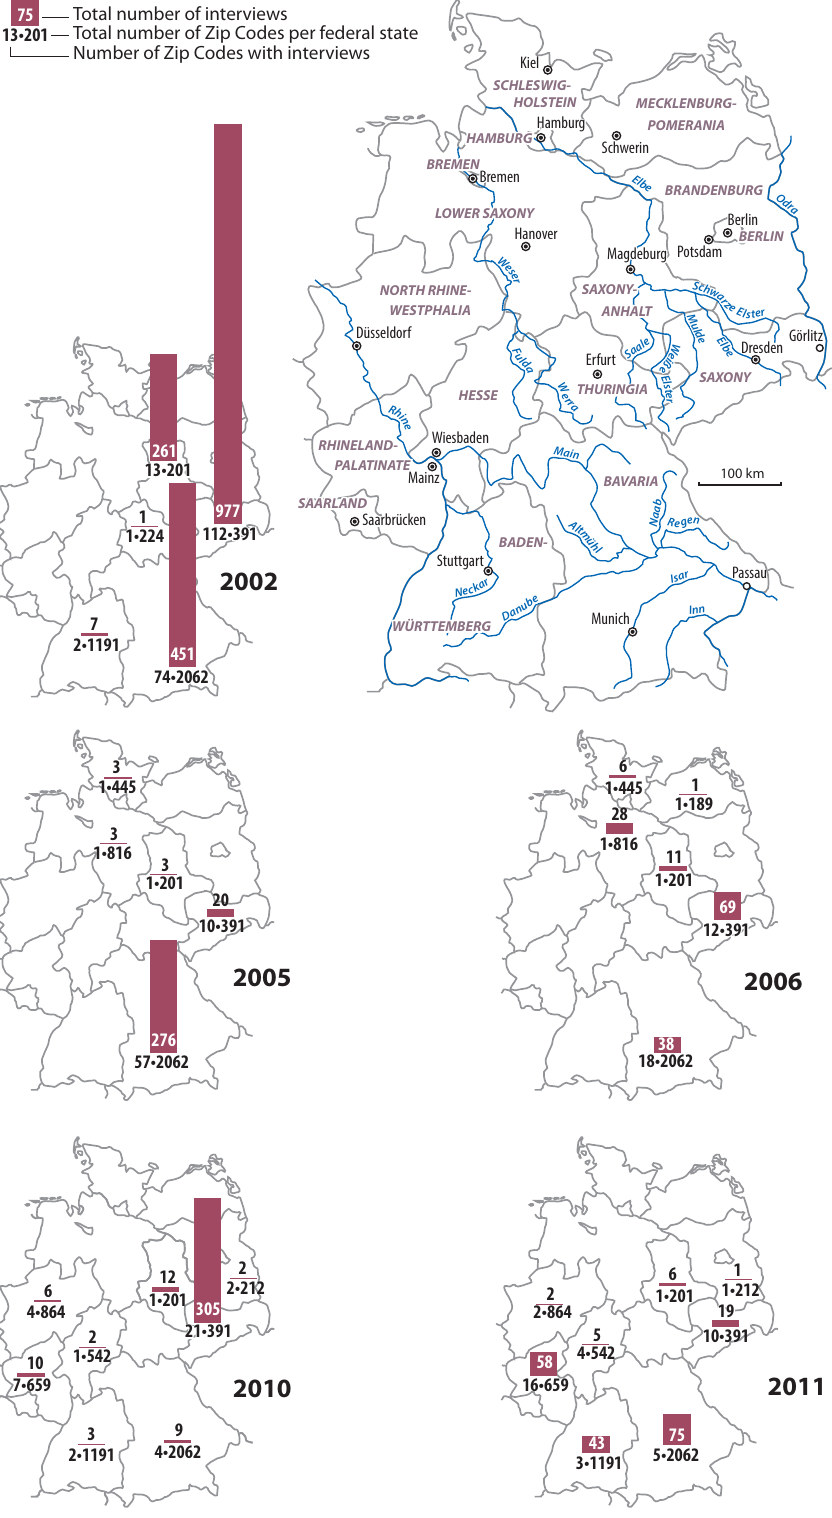
Figure 1. Federal states in which interviews of the respective subsamples were